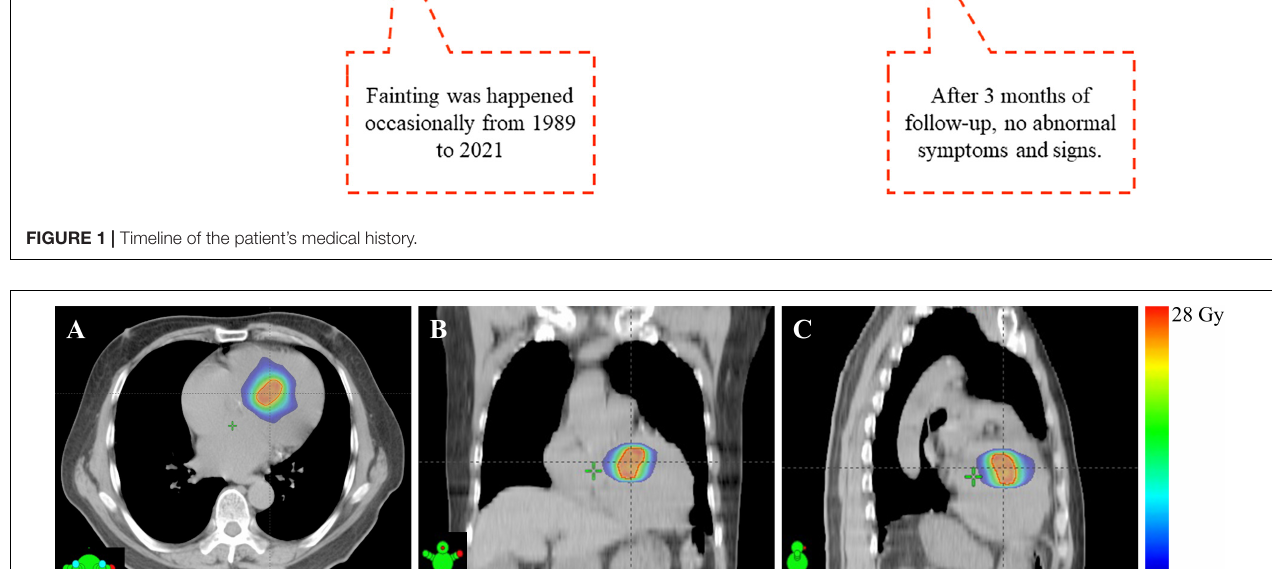
Frontiers in Medicine |